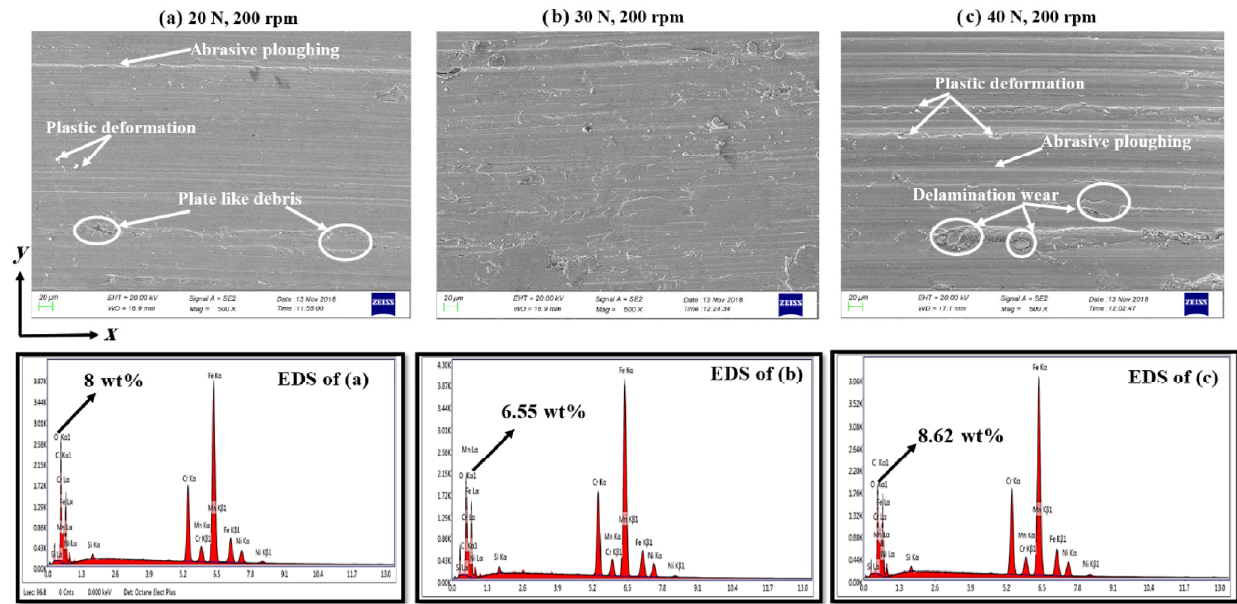
Fig. 14 SEM micrographs of AISI 304 steel pin under different normal loads at N rot = 200 rpm after 5 min wear test: (a) F N = 20 N, (b) F N = 30 N, and (c) F N = 40 N ( x represents the sliding